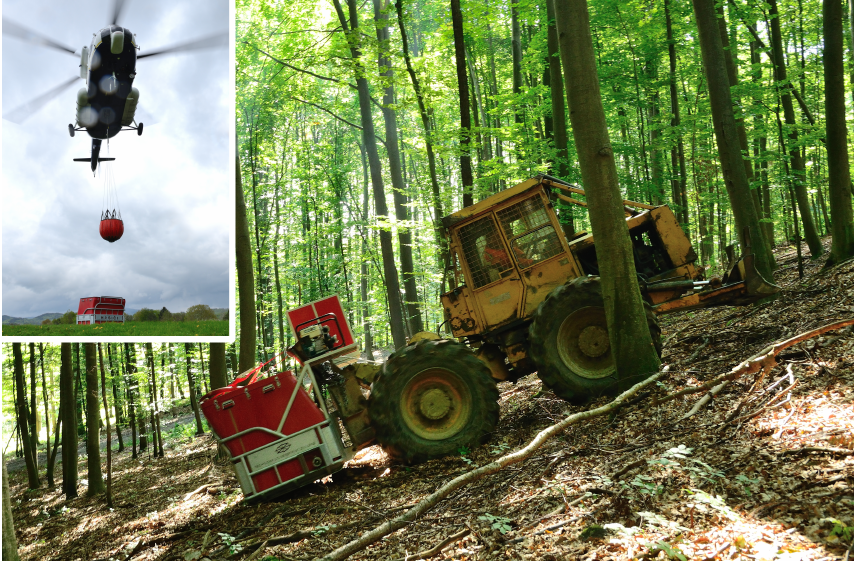
Figure 1. Firefighting adapter attached to forestry skidder. Filling water tank with Bambi